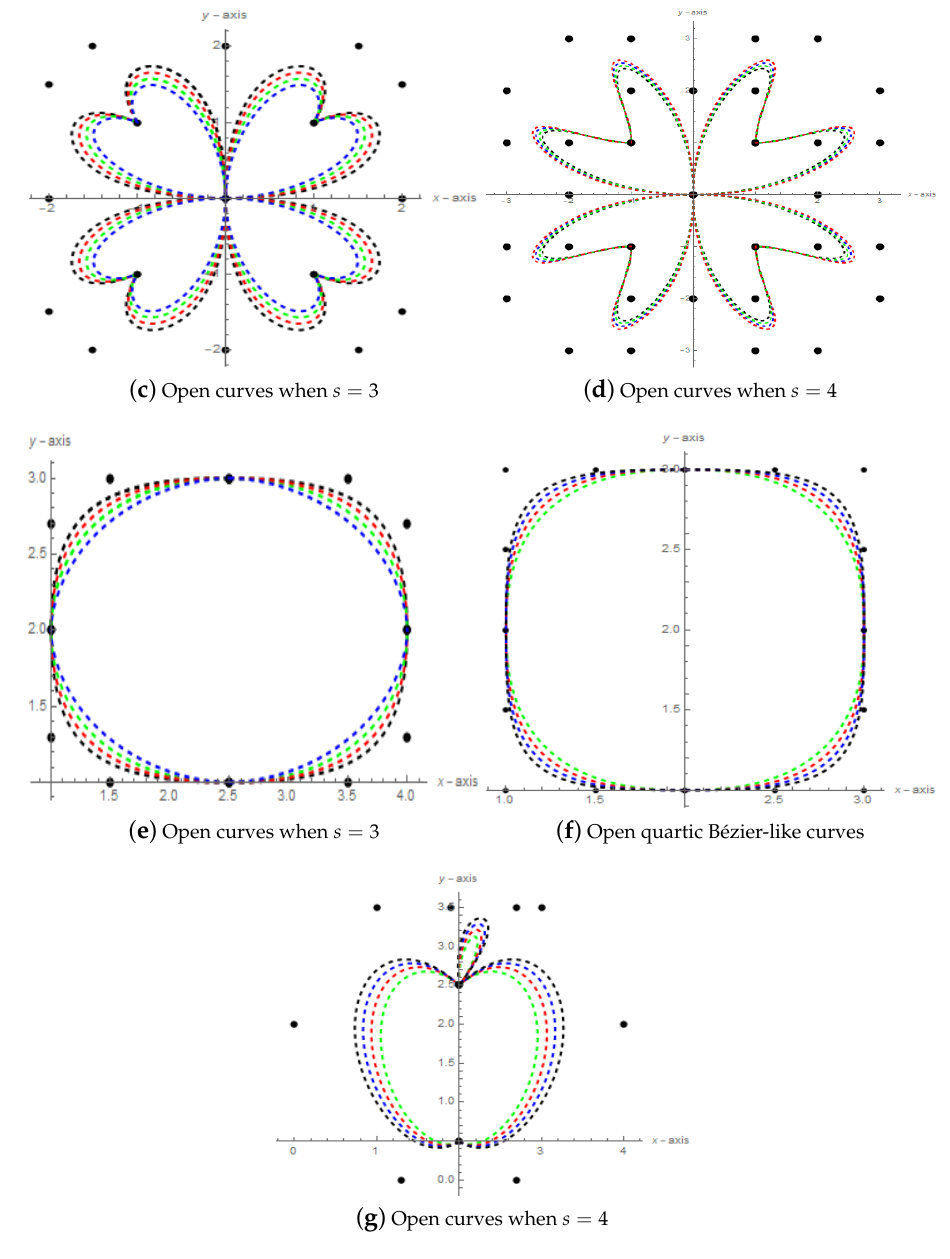
Figure 4. Free form open and closed